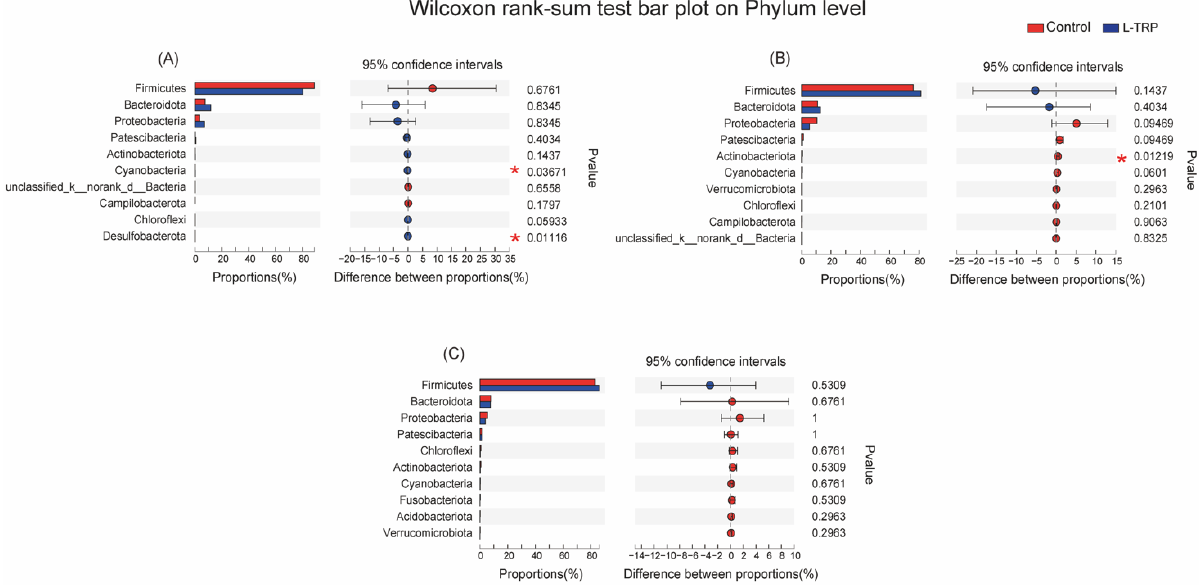
Figure 7. Differences in bacterial abundance in the intestinal microbial community of E. sinensis (phylum level) in August ( A ), September ( B ) and November ( C ). Different colored bars indicate different groups, and the rightmost value was the p -value that showed bacterial abundance differences between the control and L-TRP groups, * 0.01 < p ≤ 0.05.